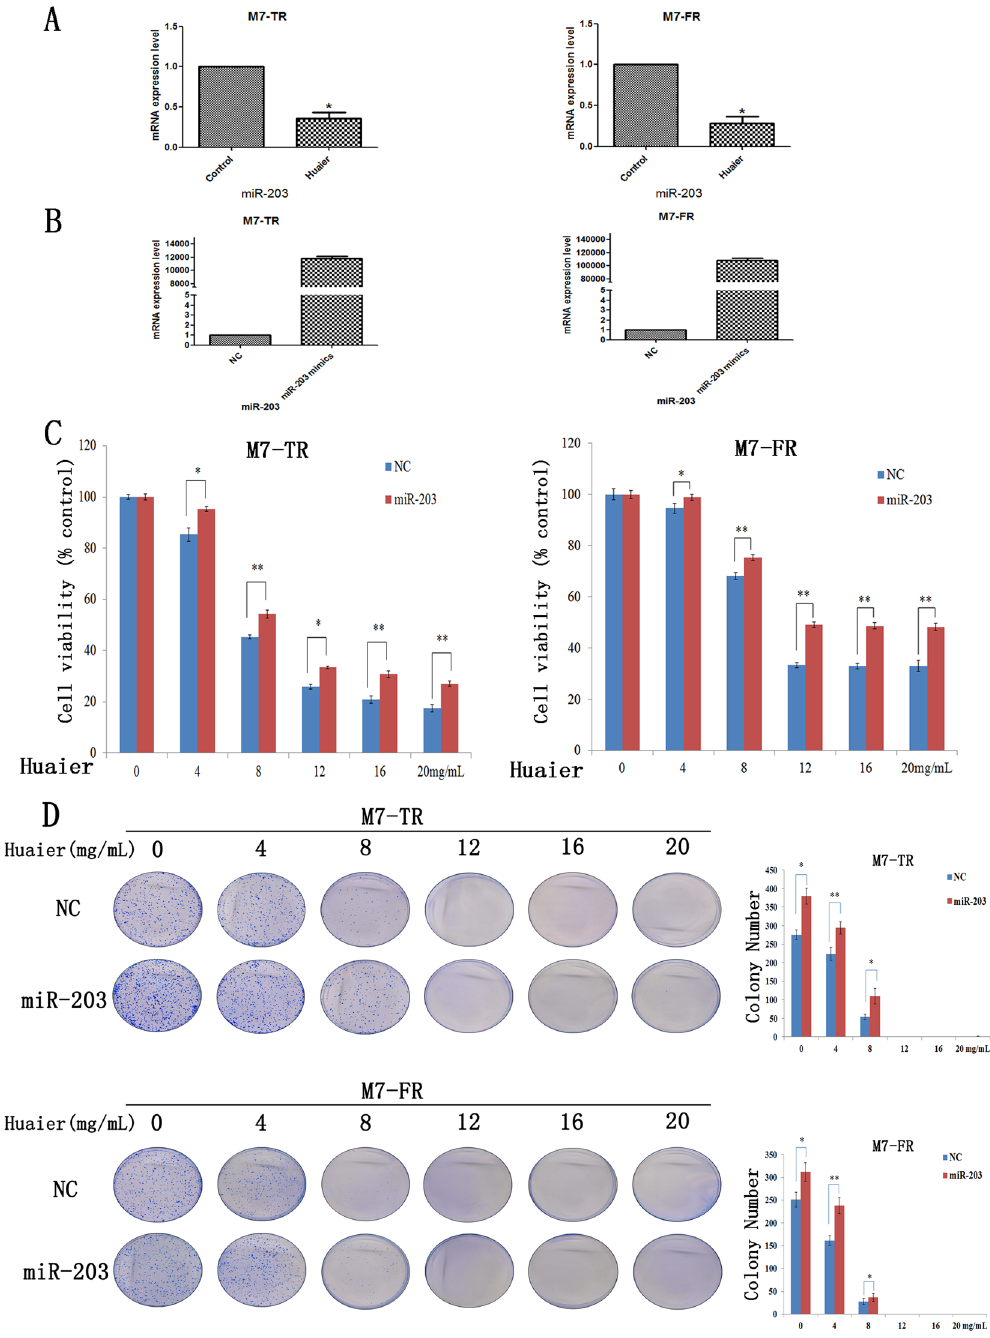
Figure 4. miR-203 is downregulated by Huaier extract in M7-TR and M7-FR cells. ( A ) Several miRNAs were detected in M7-TR and M7-FR after treatment with Huaier extract for 48 h. ( B ) miR-230 overexpressed by miR- 203 mimics in M7-TR and M7-FR cells. ( C ) Overexpression of miR-203 in M7-TR and M7-FR cells; MTT assay was performed to detect the cell viability after treatment with different concentrations of Huaier extract for 48 h. ( D ) Overexpression of miR-203 in M7-TR and M7-FR cells. Representative images and the colony formation rate of M7-TR and M7-FR cell colonies after treatment with Huaier extract for 24 h. * P < 0.05 or ** P < 0.01, compared with the controls. The data are presented as the mean ± SD of three separate